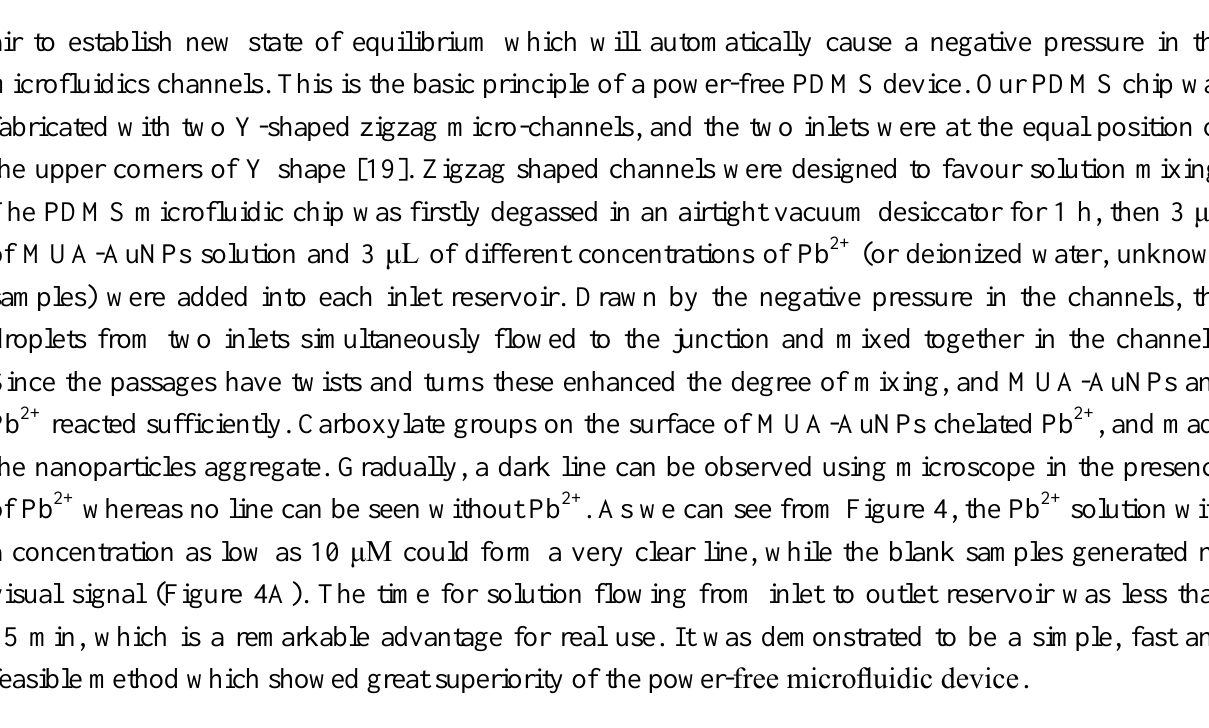
Figure 4. Microscope images of the analysis results for different concentration of Pb 2+